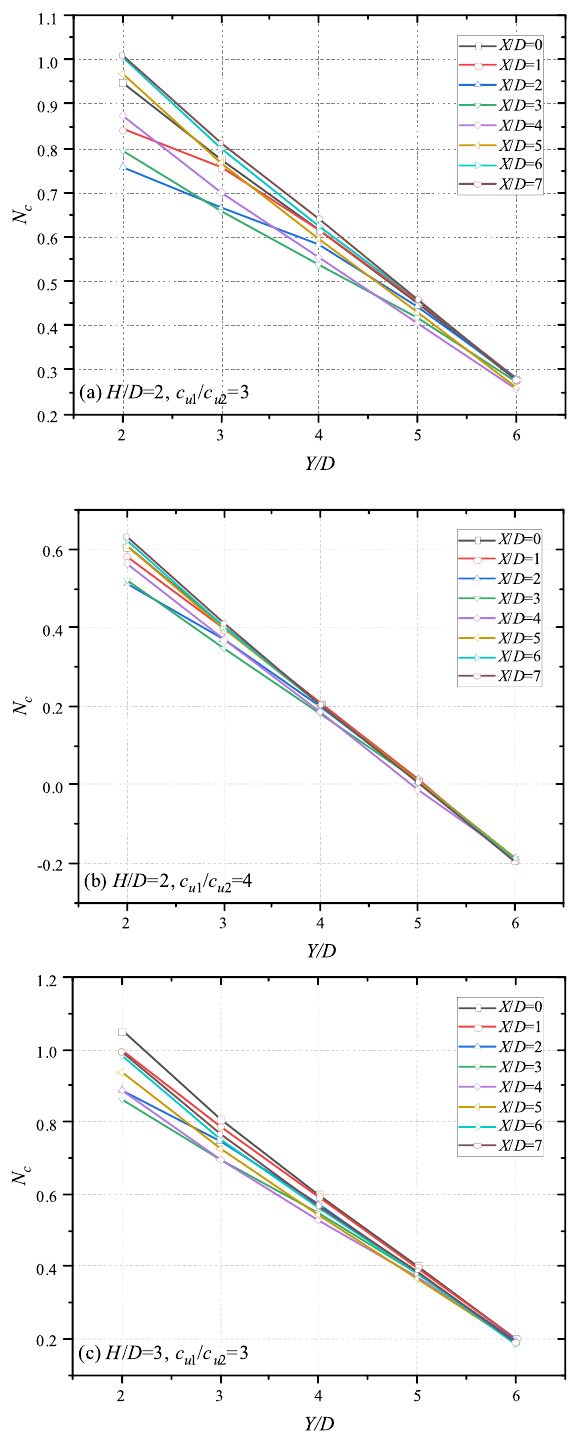
Figure 6. Variation of N c with different Y / D and X / D for ( a ) H / D = 2, c u1 / c u2 = 3; ( b ) H / D = 2, c u1 / c u2 = 4 and ( c ) H / D = 3, c u1 / c u2 =